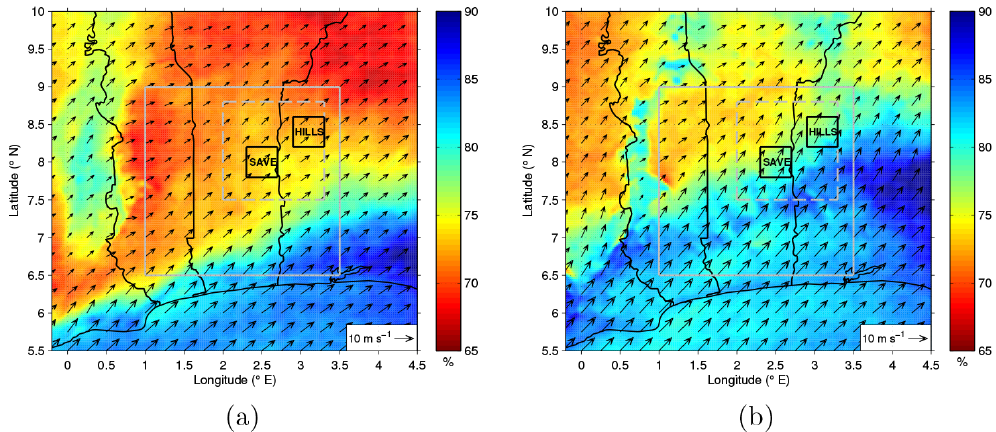
Figure 5. Spatial distribution of relative humidity (colour-coded) and horizontal wind (arrows) at 950hPa at 14:00UTC (a) and 21:00UTC (b) averaged for the months of July and August 2006. Data are from the 2.8km simulation.